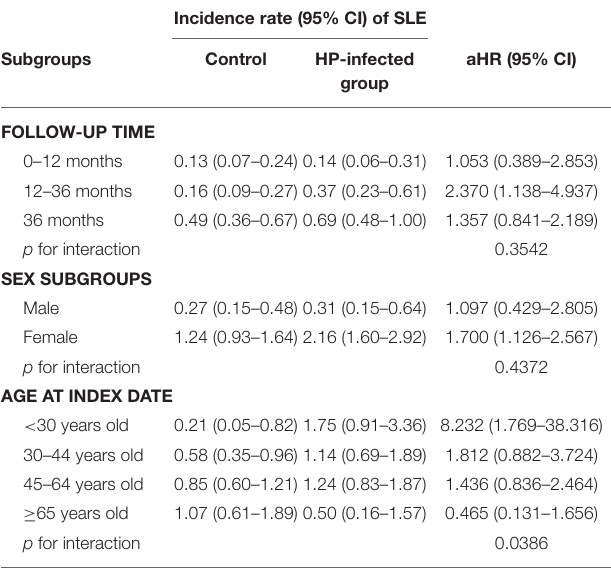
TABLE 4 | Sensitivity analysis for the adjusted hazard ratios (aHRs) stratified by follow-up time, sex, and age groups. Incidence rate (95% CI) of SLE